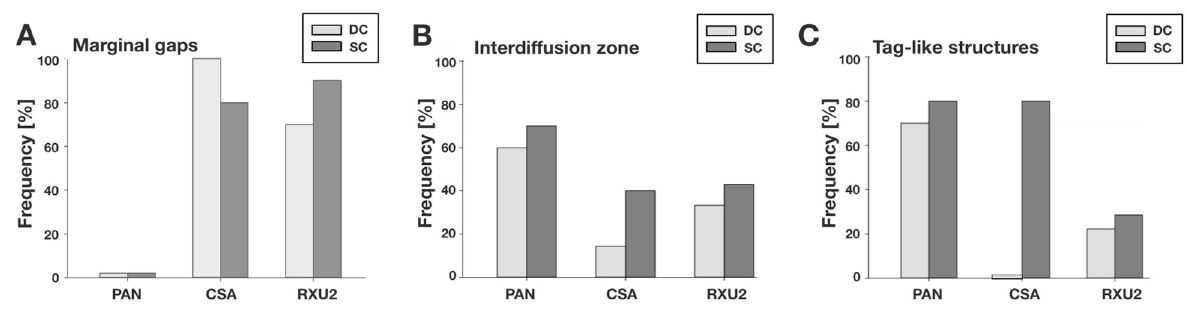
Figure 6. Frequency (percent of specimens with the respective findings of the adhesive interface micromorphology) by luting agent, after dual-curing (DC) or self-curing (SC) based on 10 polished specimens per group (experiment 1). ( A ) Marginal gaps between enamel and luting agents (n = 10). ( B ) Interdiffusion zones from the central or lateral dentin area were evaluated in each of the 10 specimens per group. The criterion was rated as present in the respective specimen if it was found in at least one of the two evaluated micrographs (central or lateral dentin). ( C ) Tag-like structures from the central or lateral dentin area were evaluated in each of the 10 specimens per group. The criterion was rated as present in the respective specimen if it was found in at least one of the two evaluated micrographs (central or lateral dentin).